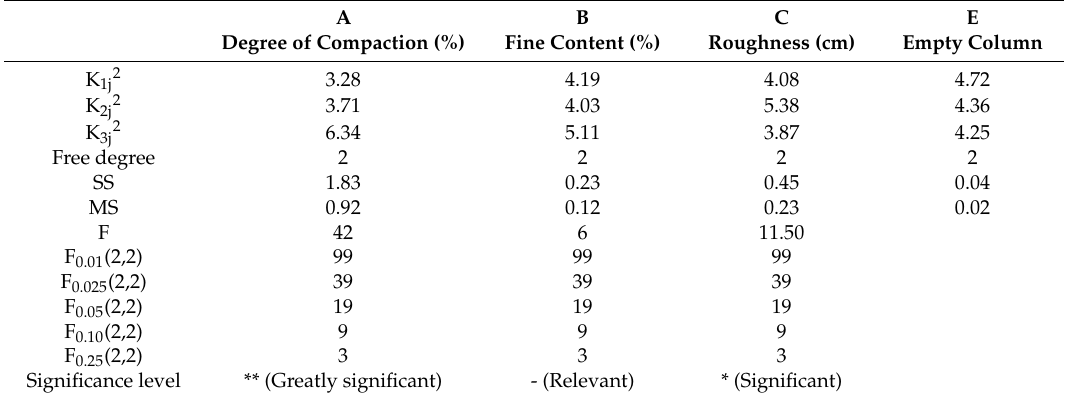
Table 7. Variance analysis results of interface internal erosion.